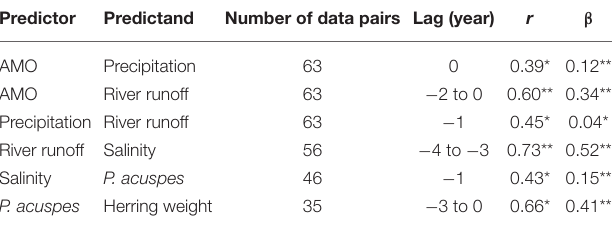
TABLE 1 | The table displays the results of the statistical downscaling: the predictor and predictand, the time lag in year, the CCA correlation coefficient r and the Brier based skill score β (Livezey,